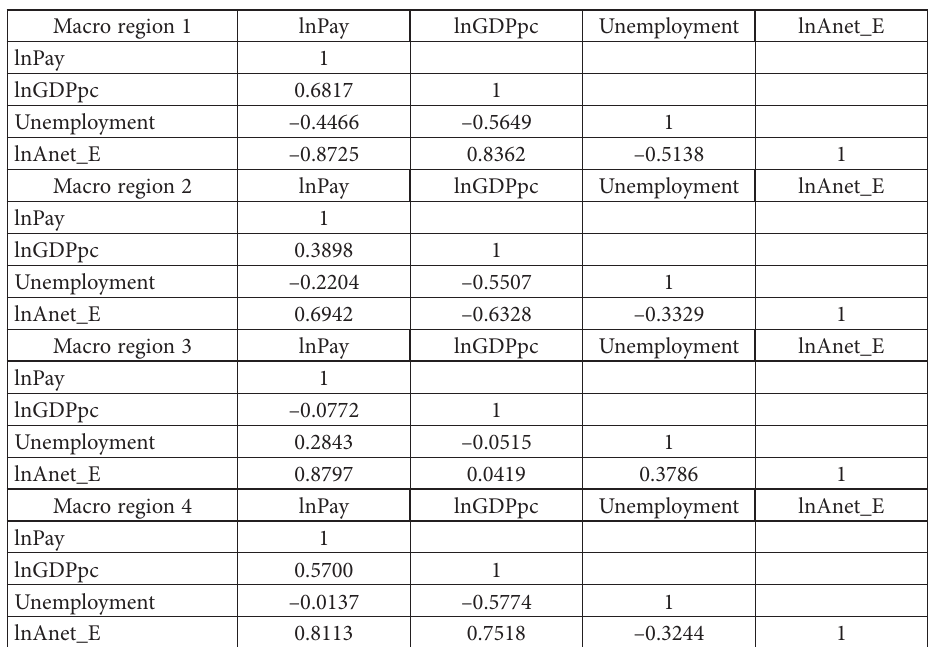
Table 4. Correlation